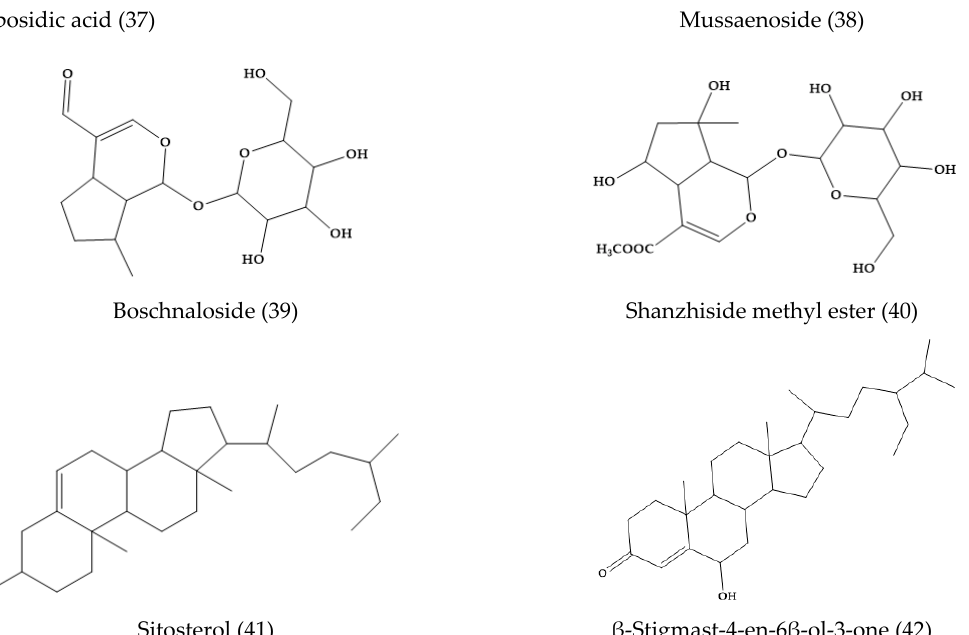
Figure 7. Selected phytochemicals from Veronica anagallis-aquatica and others.